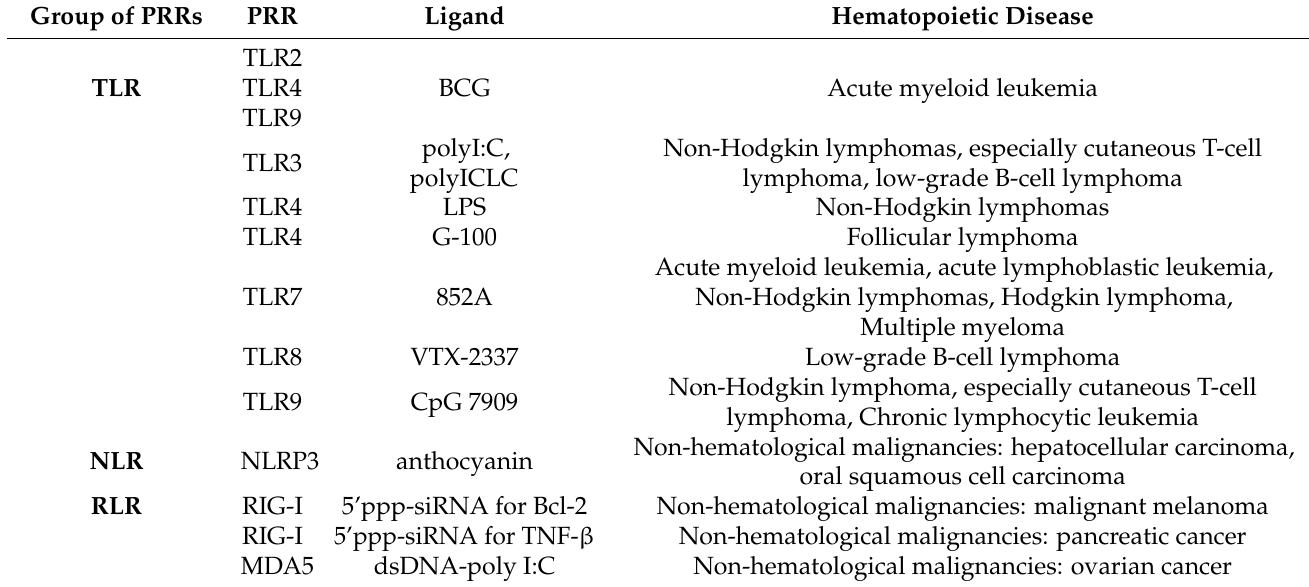
Table 4. Ligands for PRRs in the treatment of hematopoietic diseases. References in the text. Group of